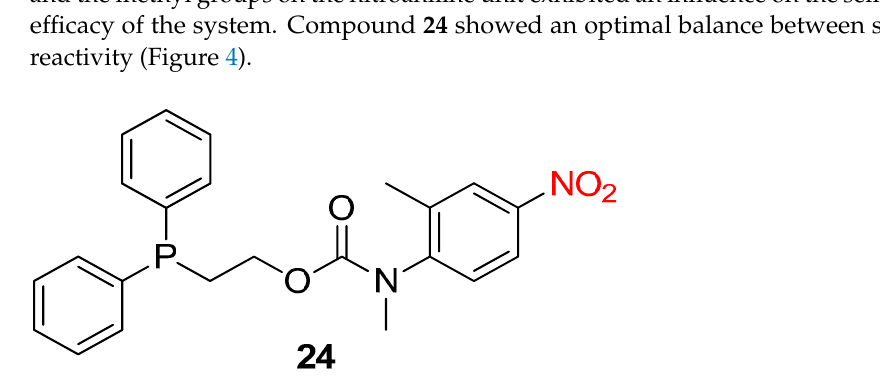
Figure 4. Best self-immolative system 24 for disclosure of reactive electrophilic alkylating agents .